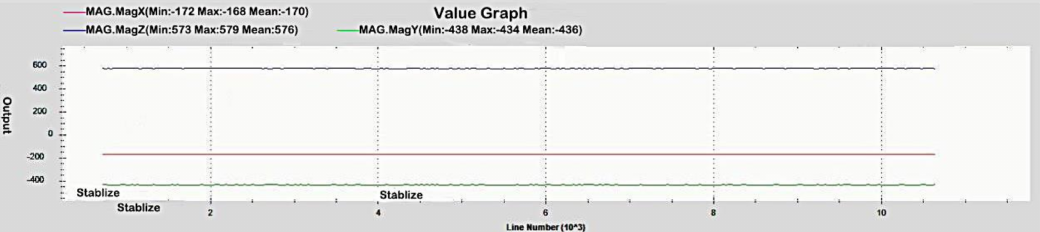
Figure 3. The magnetic field was small, and the UAV was placed in a place where the magnetic field was normal and there was no electromagnetic or magnetic interference around it. This is the graph of the magnetometer data collected at this time. The curve in the graph is the sampling point curve, where the unit of the vertical axis is degree.